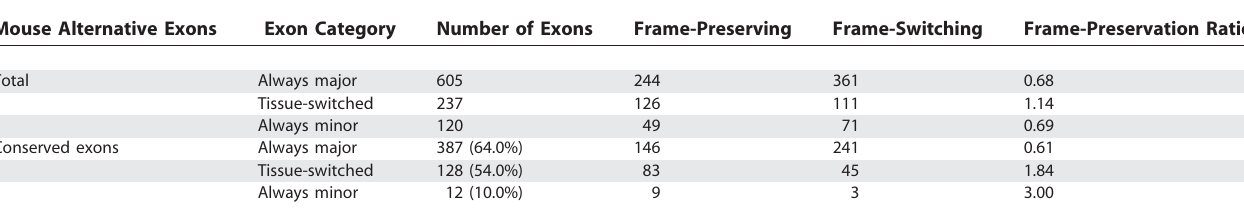
Table 1. Frame Preservation Analysis for the Total and Conserved Sets of Always Major, Tissue-Switched, and Always Minor Exons Mouse Alternative